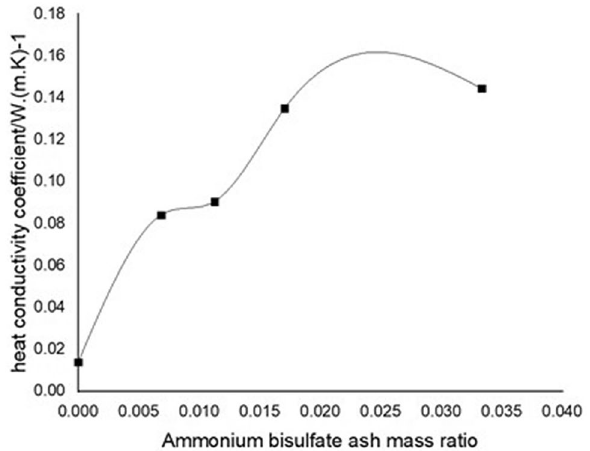
Figure 5. Variation curve of fly ash thermal conductivity under different ammonium bisulfate content 37 .